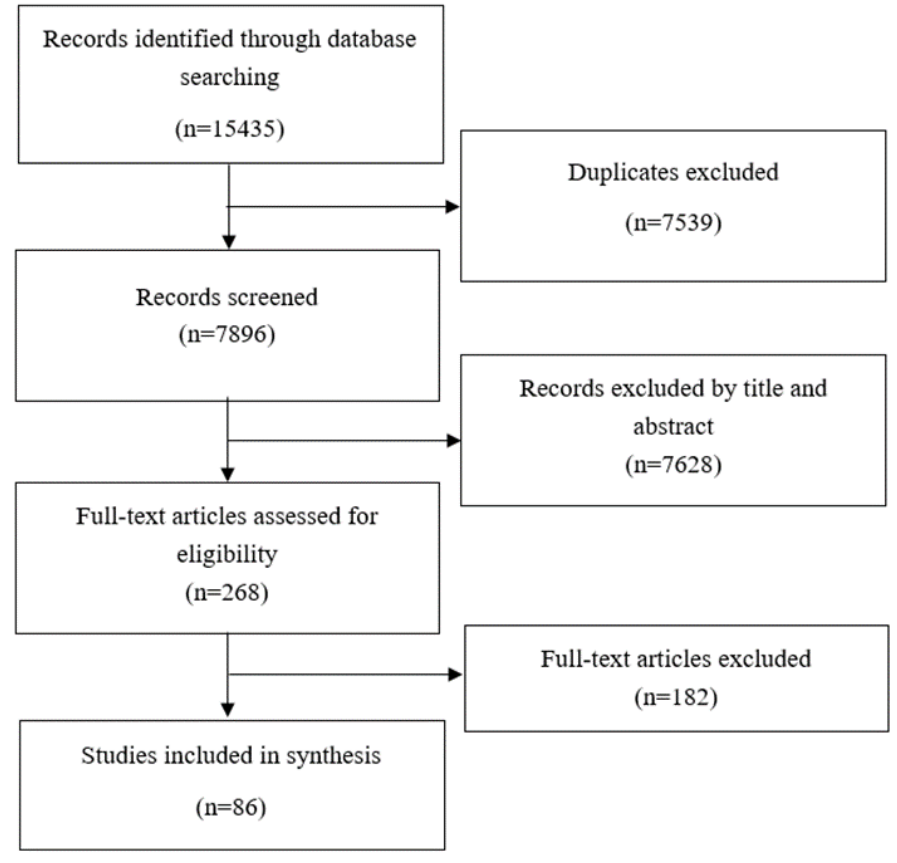
Figure 2. PRISMA (Preferred Reporting Items for Systematic Reviews and Meta-Analyses)